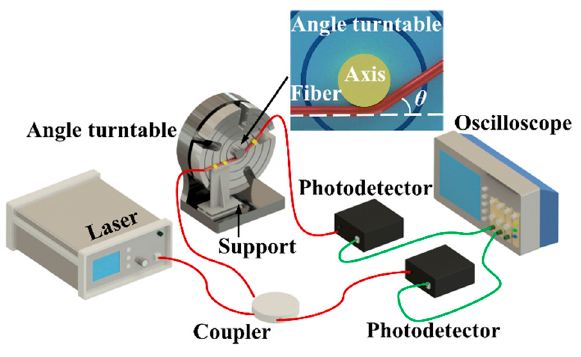
Figure 2. Schematic illustration of angle calibration experiment for the developed POF sensor.